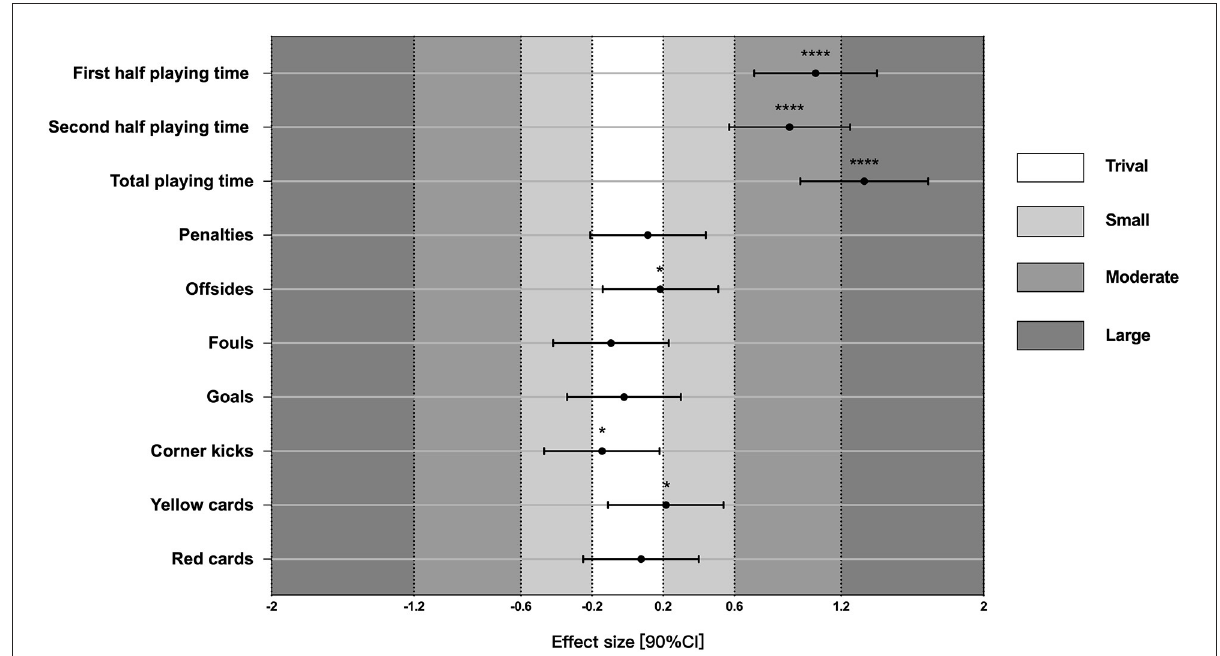
FIGURE1 Effect sizes of differences in each match variable before and after the introduction of VAR. Asterisks indicate the qualitative likelihood of the magnitude of true effects: * possibly ; **** most likely ; CI, confidence